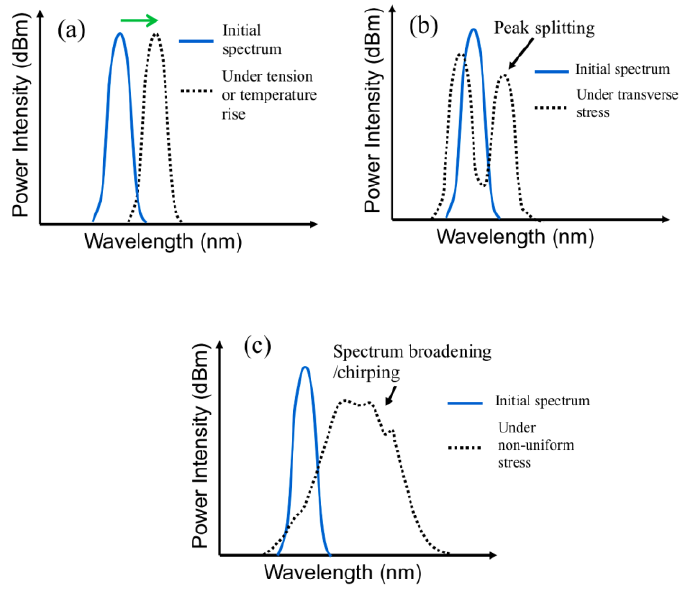
Figure 2. Schematic diagram to show FBG spectrum changes under ( a ) tensile stress or temperature rise, ( b ) transverse stress, and ( c ) non-uniform stress along its length.